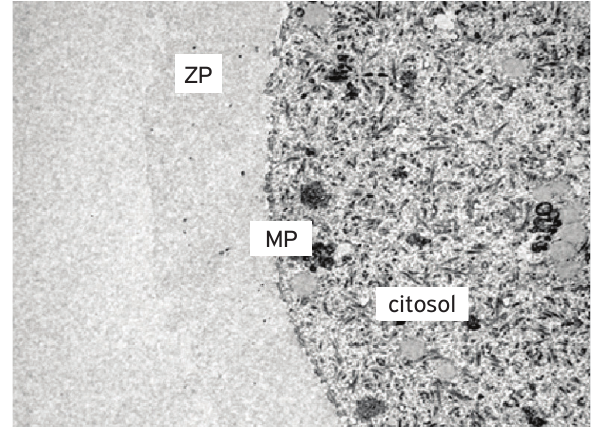
Figura 13. Embrião exposto aos vírus e ao extrato etanólico da casca de Punica granatum (Grupo G MP: membrana plasmática. Todas estruturas